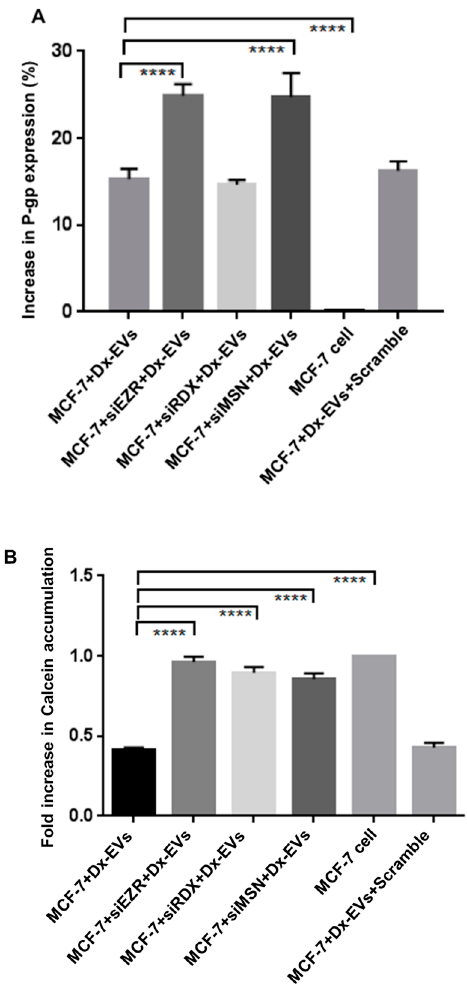
Figure 6. Effect of gene silencing in the recipient cell on vesicular transfer of P-gp and drug efflux. MCF-7 cells were silenced with siRNA targeting, Ezrin (siEZR), Radixin (siRDX), Moesin (siMSN), and following which cells were co-cultured with MCF-7/Dx-EVs for 4 h.; ( A ) P-gp expression and ( B ) Calcein-AM uptake was evaluated by FCM. Data represents mean ± SD (n = 3). **** p < 0.0001.